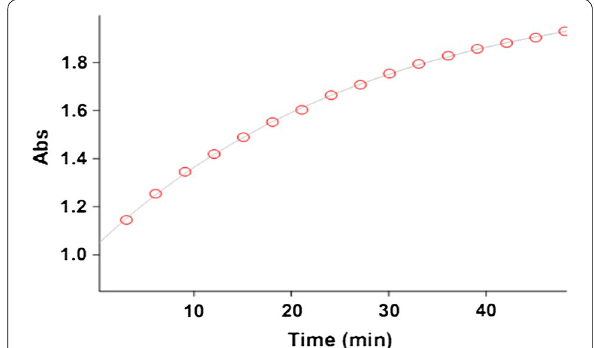
Fig. 5 Plot of absorbance versus time at 305 nm for the reaction between ( 1 ) (10 − 2 M), ( 2 ) (5 10 − 3 M) and N – H (5 10 − 3 M) in × × methanol. The dotted curve shows experimental values, and the solid line is the fitted